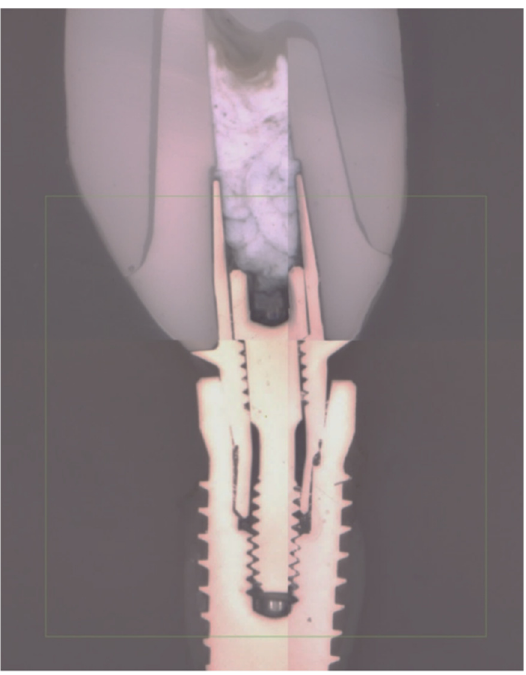
Figure 4. Representative cross-section micrograph of the implant–abutment–crown configuration after the static loading test.